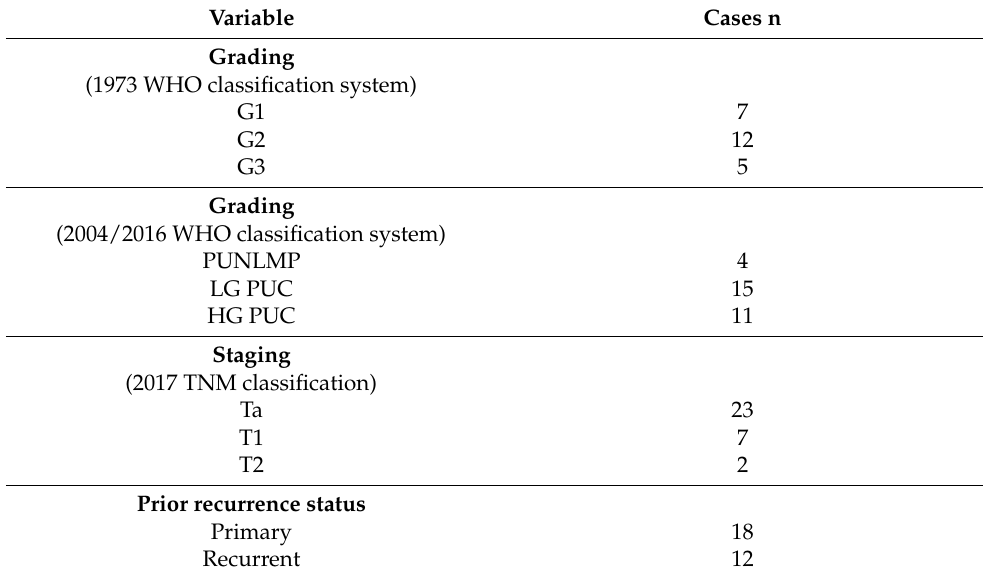
Table 2. Histopathological characteristics of bladder